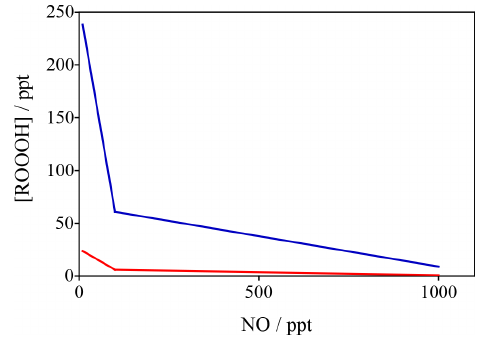
Figure 10. Variation in ROOOH as a function of NO ( x axis) and VOC reactivity (different colours) constrained by data from Feiner et al. (2016). These data in red reflect a situation of VOC reactiv- ity of 5s − 1 whilst the blue data reflect a VOC reactivity of 24s − 1 (similar to that seen in regions like the